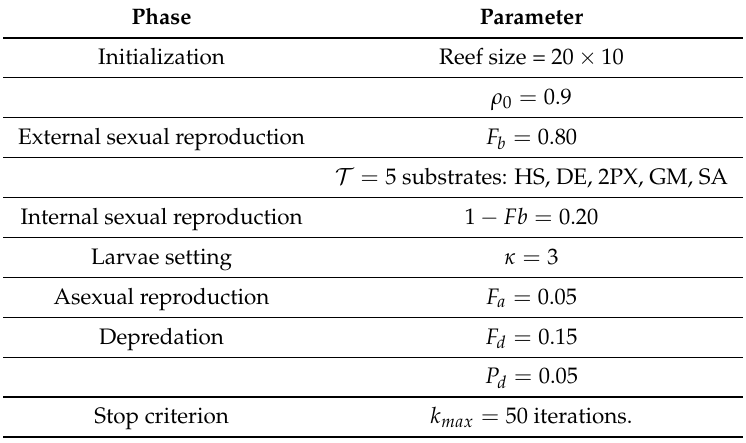
Table 2. CRO-SL optimization parameters. GM, Gaussian Mutation; SA, Strange Attractors.